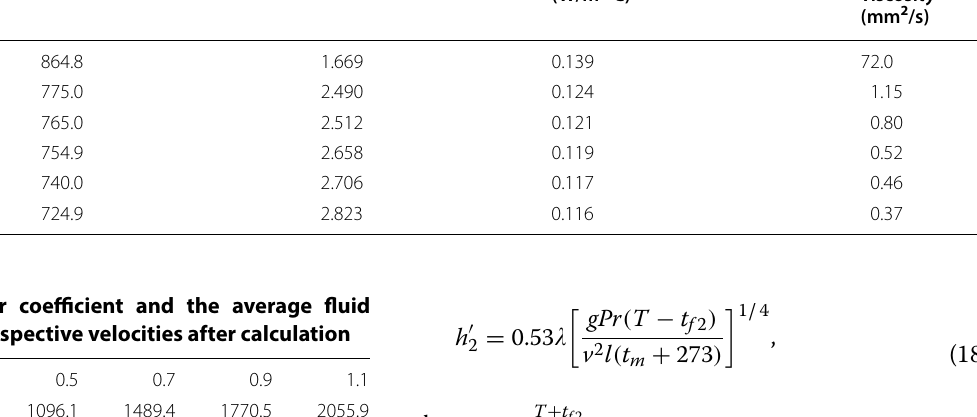
Table 1 Physical property parameters of heat conducting fluid L-QD330 Temperature (°C)